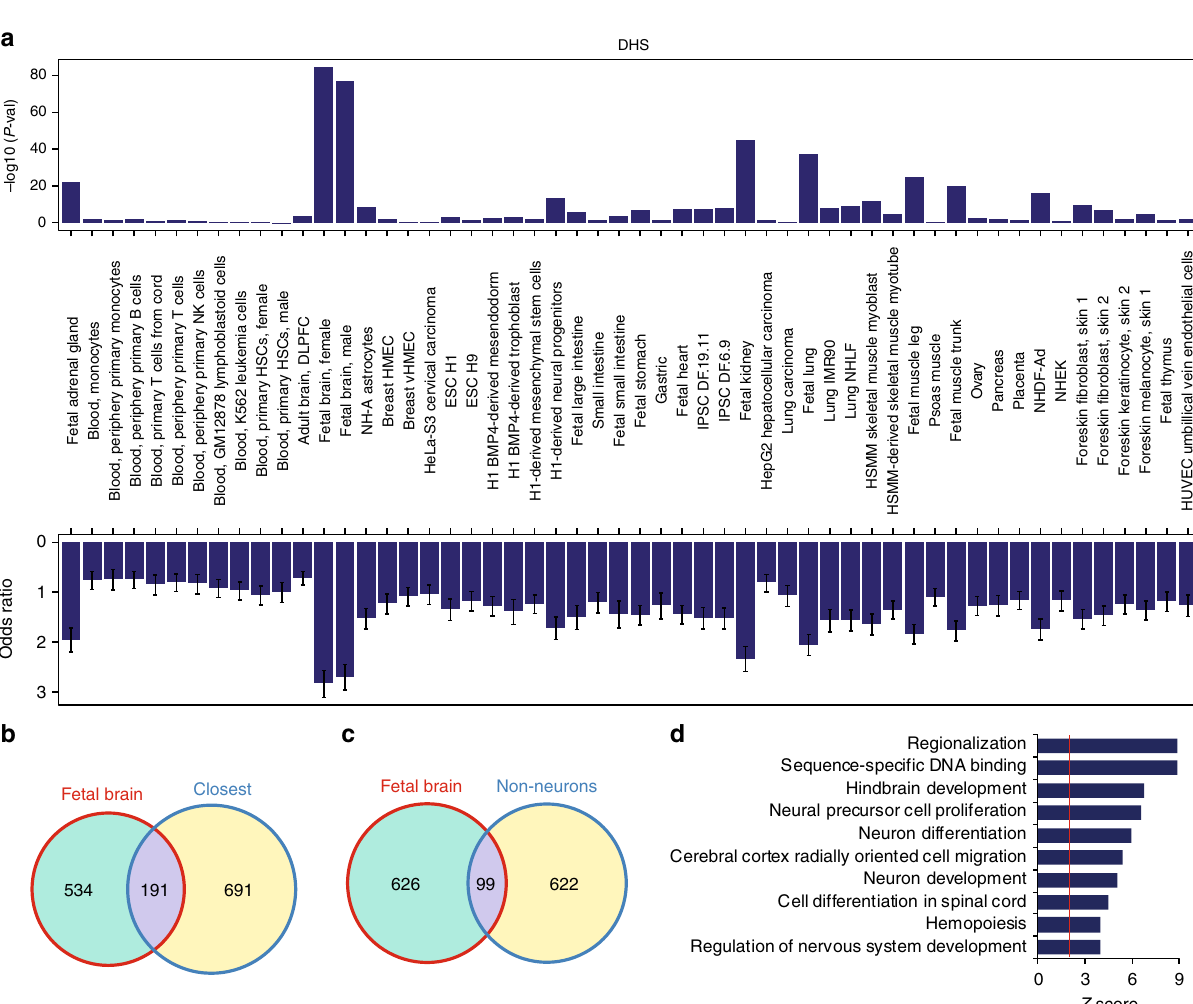
Fig. 1 HARs interact with genes that regulate human brain development. a DHS enrichment of HARs in different cell/tissue types after controlling for evolutionary conservation (Methods). HSCs, hematopoietic stem cells; NK cells, natural killer cells; DLPFC, dorsolateral prefrontal cortex. P -values and odds ratio calculated by Fisher ’ s exact test. Error bars denote for 95% con fi dence intervals (CI). b Overlap between nearest genes to HARs (closest) with genes that interact with HARs in developing brain (fetal brain). c Overlap between genes that interact with HARs in developing brain (fetal brain), and non- neuronal cell types (non-neurons) 10 . Protein-coding genes were used for Venn diagrams. d Gene ontology enrichment for HAR-associated